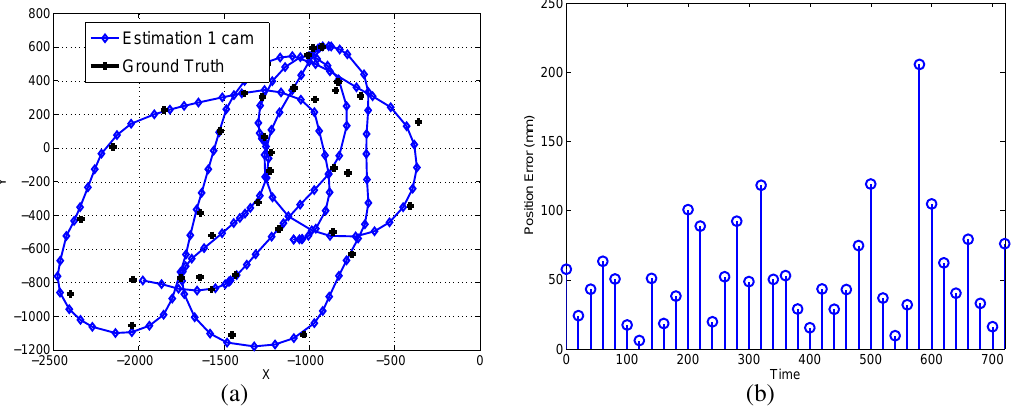
Figure 13. Online robot’s pose compared with the “ground-truth”.